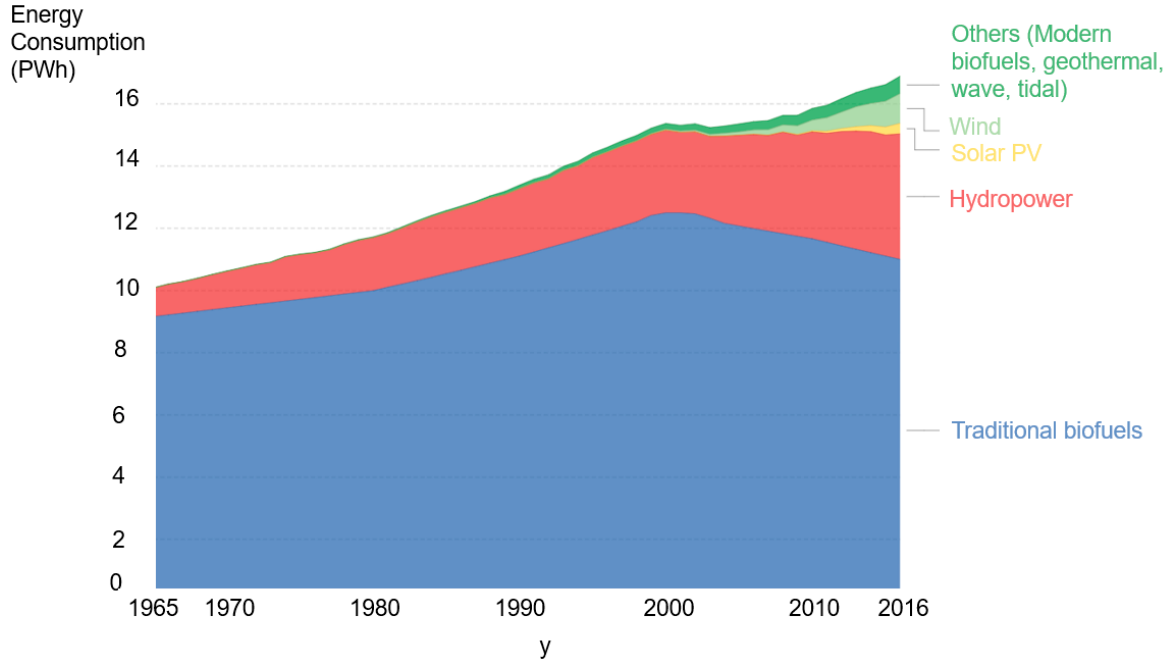
Figure 2. Global renewable energy consumption, adapted from Ritchie and Roser [19].